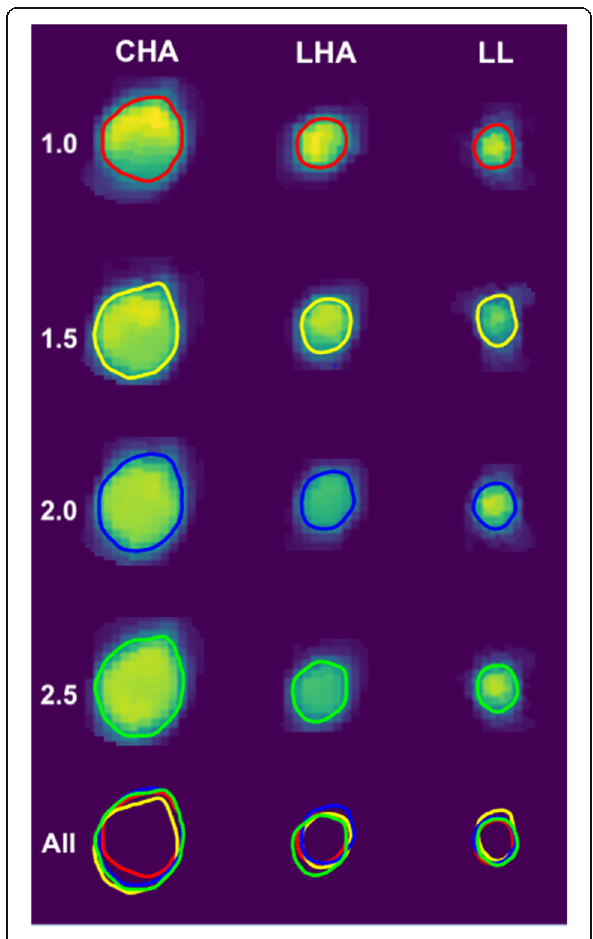
Fig. 5 4D-DSA area segmentation of common hepatic artery (CHA, left column), left hepatic artery (LHA, middle column), and left lateral artery (LL, right column) for increasing injection rates from 1.0 to 2.5 mL/s while other parameters were kept identical (12-s scan time, 100% contrast concentration and 4-Fr catheter size). The final row demonstrates the overlapping of all segmentations for different injection rates for the individual